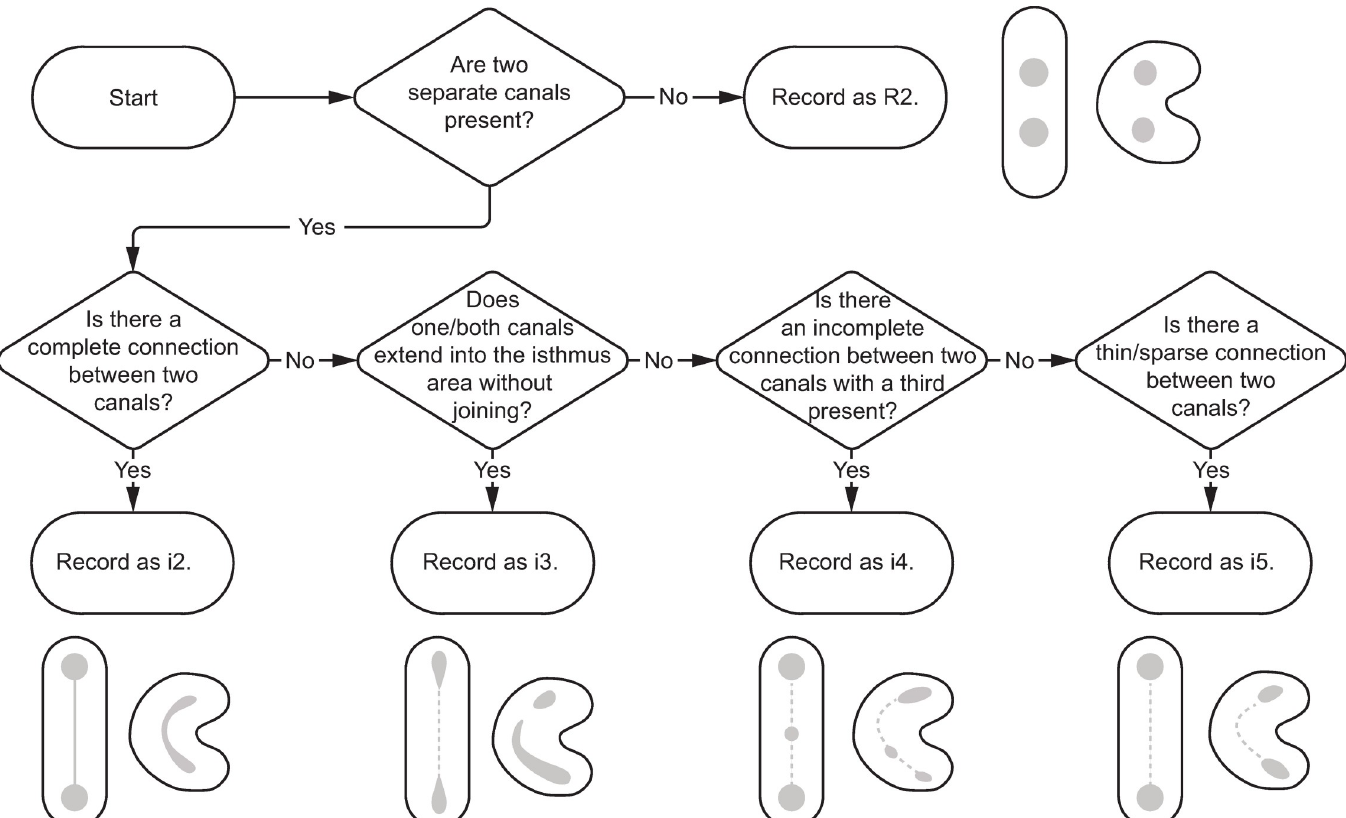
Fig 18. Flow chart for determining and recording phenotype element 5—canal morphology and configuration (isthmus canals). Illustrations show external root morphologies including C-shaped root variants. Canal shape/configuration is in gray.